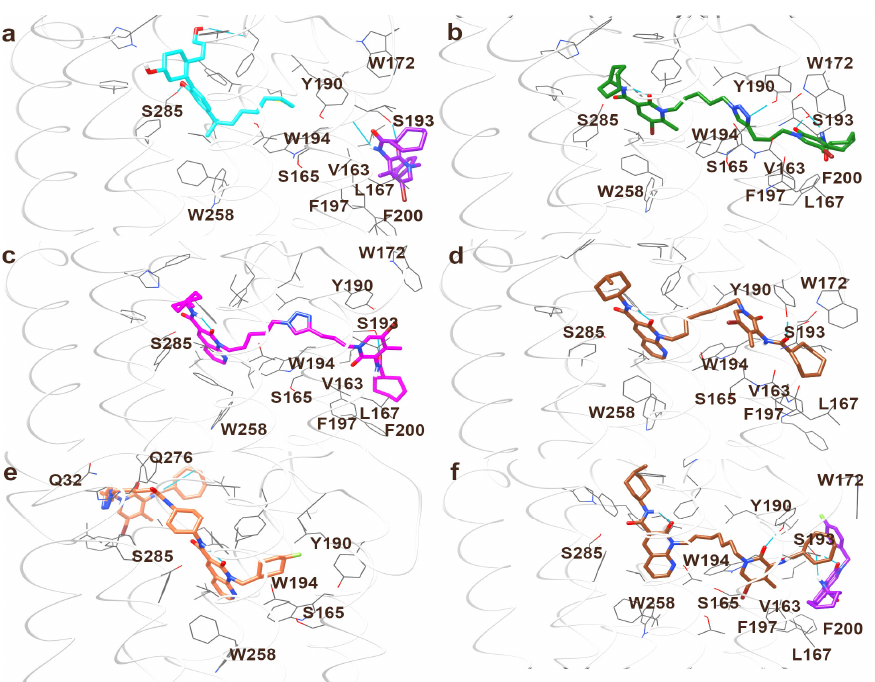
Figure 7. Optimized docking poses of: ( a ) CP55,940 and EC21a in ternary complex with CB2R; ( b ) FD22a , ( c ) JR22a , ( d ) JR64a , ( e ) JR14a in complex with CB2R; ( f ) JR64a and EC21a in ternary complex with CB2R. Hydrogen bonds are represented in cyan lines. The ribbon of residues 162–172, near the putative allosteric site, is removed in ( a – d ) for clarity.